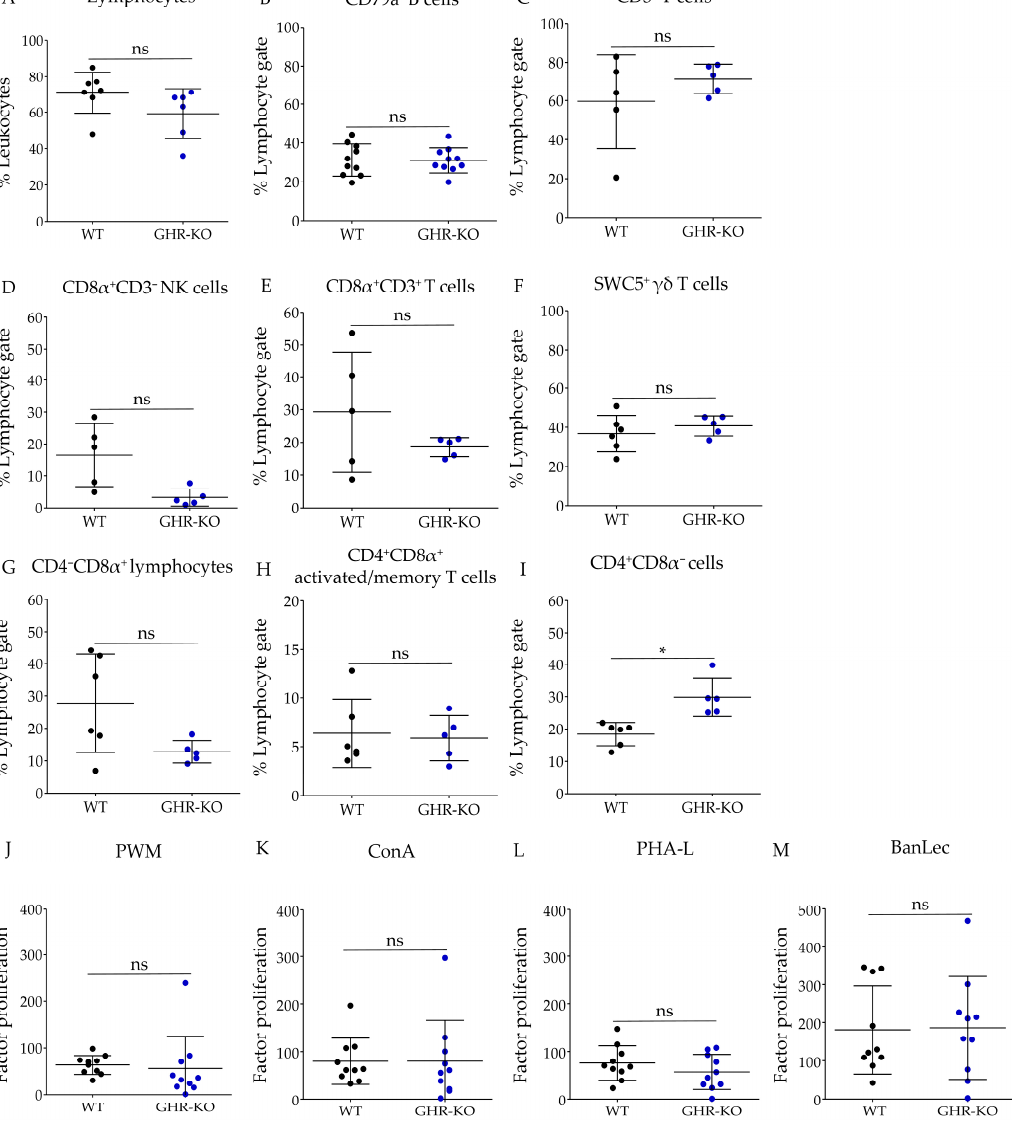
Figure 1. Lymphocyte populations, lymphocyte subpopulations and proliferative capacities of PBMC of WT and GHR -KO pigs. ( A ) Percentage of lymphocytes in the leukocytes of wild-type (WT) (black dots, n = 7) and growth hormone receptor knockout ( GHR -KO) pigs (blue dots, n = 6). Lymphocyte percentages were not significantly different between WT and GHR -KO pigs. ( B – I ) Lymphocyte subpopulations of WT (black dots, n = 16) and GHR -KO pigs (blue dots, n = 15). Proportions of ( B ) CD79a + B cells, ( C ) CD3 + T cells ( D ) CD8 α + CD3 − NK cells, ( E ) CD8 α + CD3 + T cells, ( F ) SWC5 + γδ T cells, ( G ) CD4 − CD8 α + lymphocytes, ( H ) CD4 + CD8 α + activated/memory T cells did not significantly differ between WT and GHR -KO pigs. CD4 + CD8 α − cells ( I ) significantly differed between WT and GHR -KO pigs. ( J – M ) Proliferative capacity of peripheral blood mononuclear cells (PBMCs) of WT (black dots, n = 10) and GHR -KO pigs (blue dots, n = 10) after polyclonal stimulation with ( J ) pokeweed mitogen (PWM), ( K ) concanavalin A (ConA), ( L ) phytohaemagglutinin-L (PHA-L) and ( M ) M. paradisiaca lectin (BanLec) in vitro revealed similar proliferative capacity of WT and GHR -KO PBMCs. Data are shown as mean ± SD; ns = not significant, * p ≤